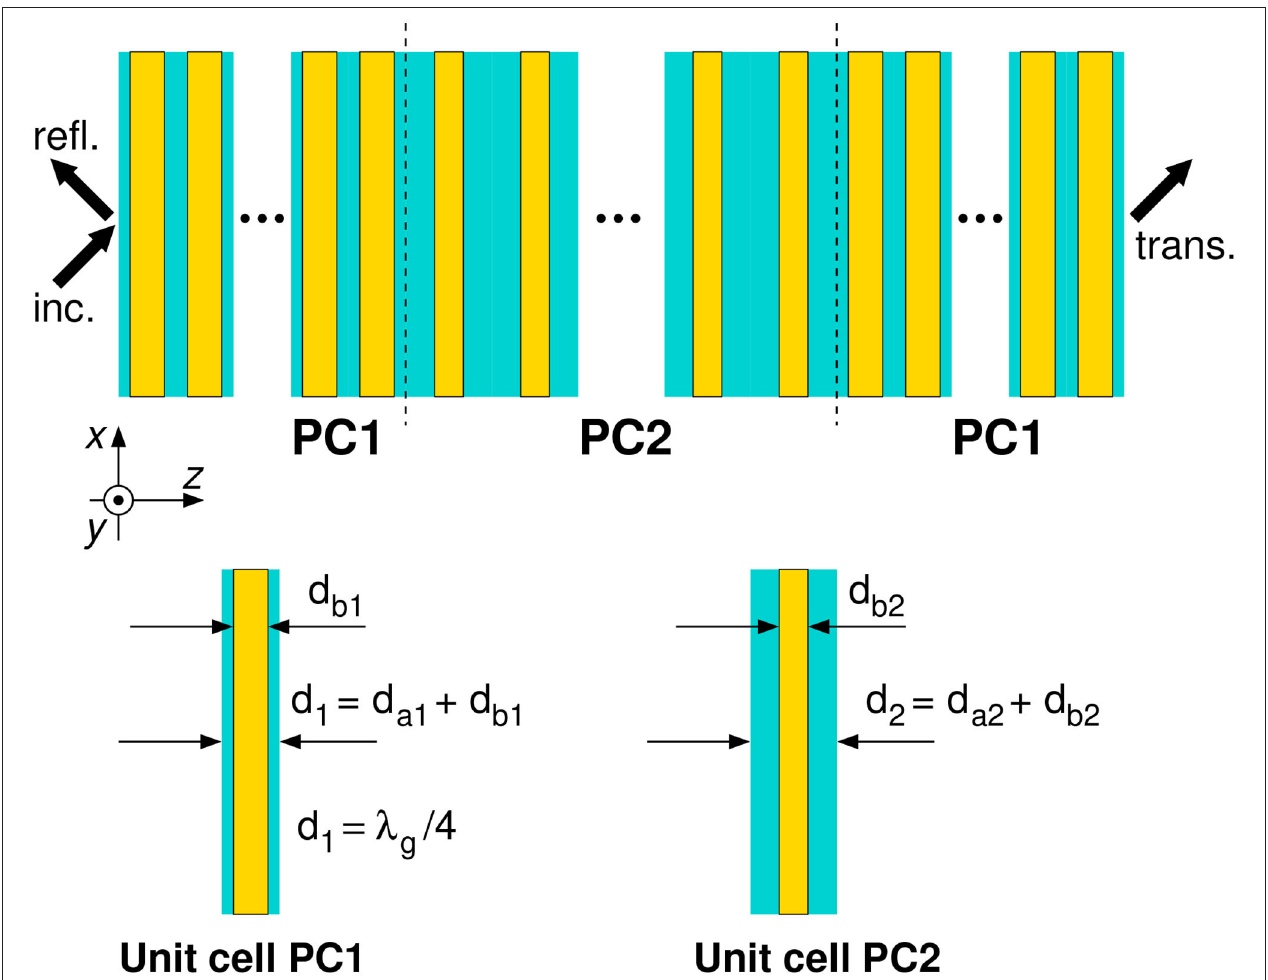
FIGURE 10 | Schematic representation of a stack based on two photonic crystals of different unit cells. The PC2 is designed in order to have a bandgap overlapping with the first bandgap of PC1, after a band inversion. Multiple edge states are formed by attaching alternately PC1 and PC2 crystals.